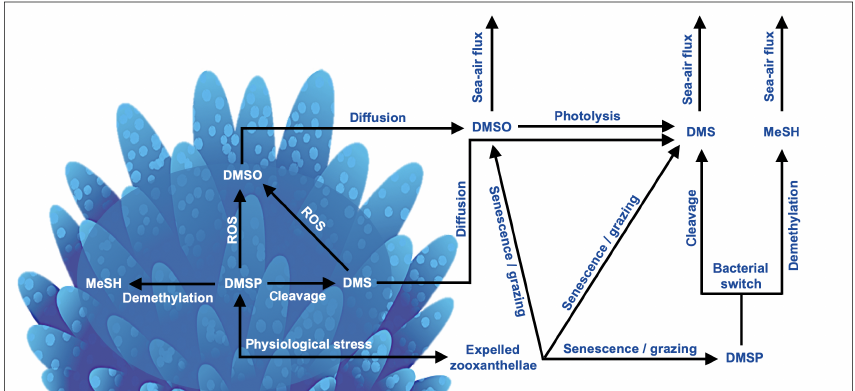
Figure 3. Basic processes involved in the cycling of dimethylated sulfur compounds involved in a coral reef. In corals, dimethylsulfoniopro- pionate (DMSP) is produced by both the coral host and endosymbiotic algae in response to physiological stress. DMSP catabolism occurs via the demethylation and cleavage pathways, yielding methanethiol (MeSH) or dimethylsulfide (DMS), respectively. DMS(P) scavenge re- active oxygen species (ROSs) produced in coral tissues and by zooxanthellae photosystems during exposure to high temperatures, irradiance and/or hyposalinity, forming dimethyl sulfoxide (DMSO). DMS(P)(O) can be released to surrounding waters via zooxanthellae expulsion, followed by cell senescence and/or grazing by zooplankton or herbivorous fish. DMS(O) may also diffuse from the coral into surround- ing waters. Dissolved DMSP may undergo microbial catabolism, yielding organic carbon or sulfur depending on bacterial needs (bacterial switch). DMS(P)(O) may sink and become stored in sediment pore water. DMS(O) may be ventilated to the lower atmosphere by wind- and temperature-driven transfer across the ocean–atmosphere interface.